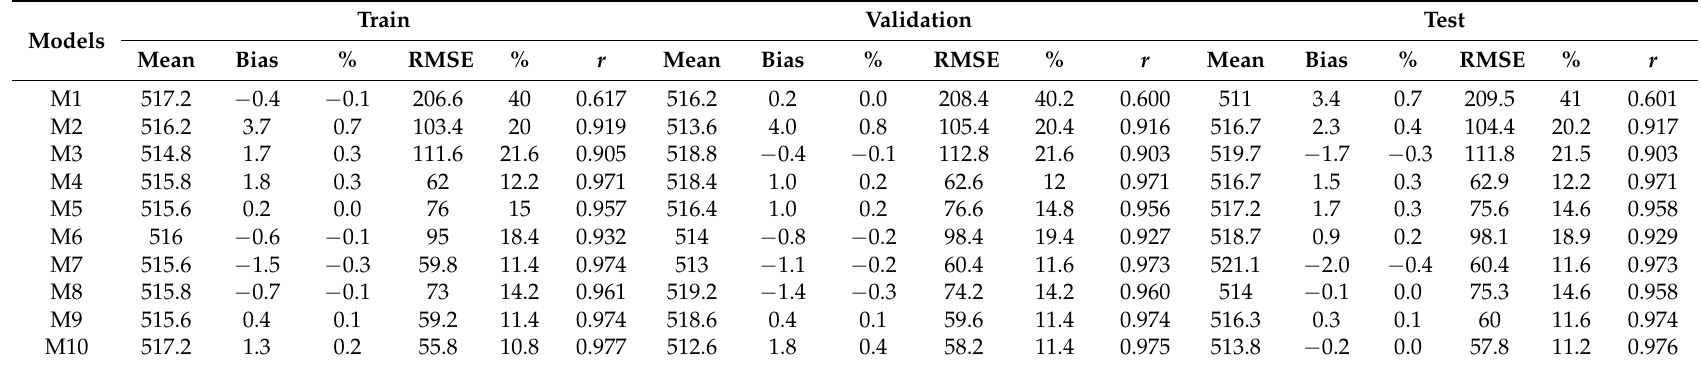
Table 5. Statistical results of hourly GHI models averaged for each model M1–M10 for tower stations . Mean, bias and RMSE units are W/m 2 .